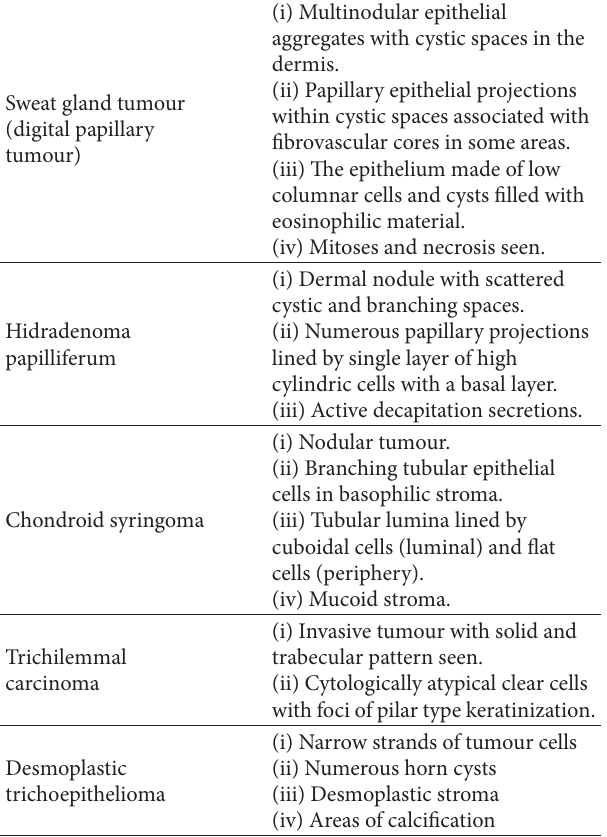
Table 9: Salient histopathological feature of troublesome tumours.